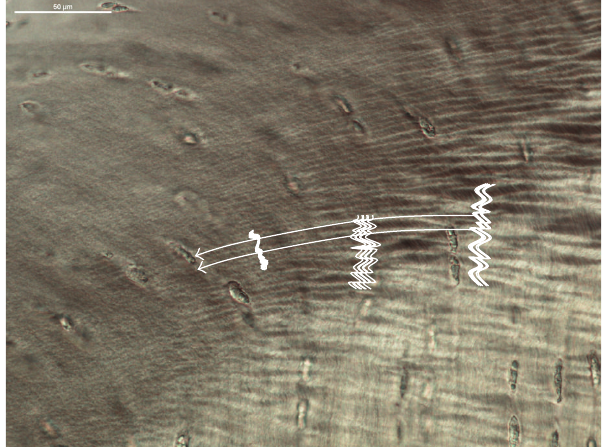
Figure 8: An overview of a Cr1 sample. The main image is a magnification of the boxed region shown in the smaller image. The solid single-headed arrows trace the curvature of chondrocyte alignment and highlight the overall lateral deformation. The dotted arrows indicate a structural discontinuity that persists all the way up to region X, the start of the bulge region, where shear bands form. Region X is imaged at higher magnification in Figures 9 and 10 and discussed accordingly. The double-headed arrow indicates the midzone chondrocyte alignment which appears to be deviated towards the bulge region. DIC imaging.